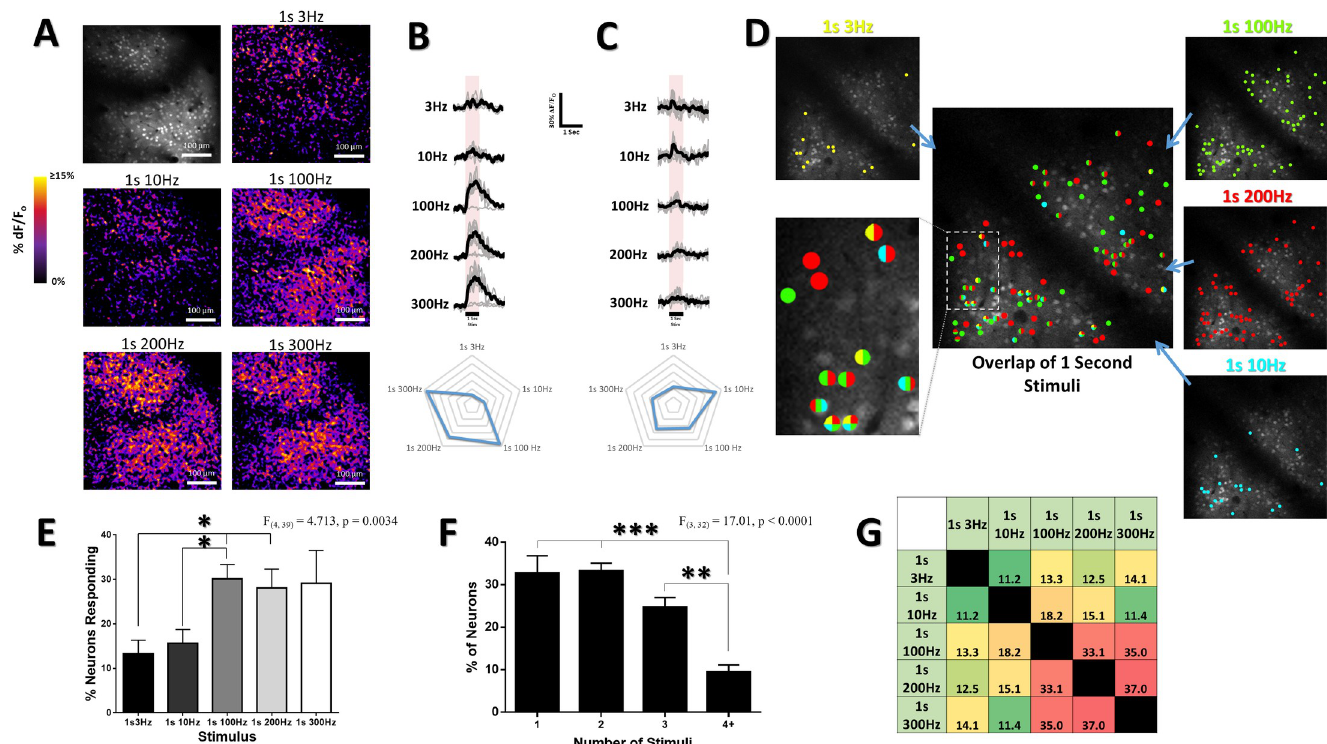
Fig 2. Neuronal and population response selectivity to stimulus frequency within the limb associated somatosensory cortex. ( A ) Difference images illustrating the averaged change in fluorescence Δ F/F o from baseline over the 1s stimulus period. Top left panel depicts an averaged image of the baseline period prior to stimulus onset within the cHL responsive region at 130um depth in an example animal. High frequency 100, 200, & 300Hz stimuli elicit greater cortical activation of neurons and neuropil than lower frequency 3 & 10Hz stimuli (quantified in Fig 3). ( B , C ) Ca 2+ traces for individual neurons responding to the different stimuli (average of 8 trials of stimulation per limb) are shown for each stimulus for the particular chosen neuron. The neuron in B is more responsive to high frequency 100, 200, & 300Hz stimulation, and displays minimal response to lower frequency 3 and 10Hz stimuli. The neuron in C responds preferentially to 10Hz stimuli. Plots below Ca 2+ traces indicate peak Ca 2+ response magnitude for each stimulus ( D ) Color coded map of responsive neurons superimposed on an optical section at 130 μ m depth in the cHL of an example animal. Neurons were deemed responsive by threshold analysis of somatic responses, with color representing above-threshold responses to stimulation at the particular frequency and duration stated. High frequency stimuli (100 & 200Hz) elicit a greater number of neurons responsive for these stimuli. The inset image displays the same color code used for each particular stimulus and shows how certain cells within this population are selective in their response to particular stimuli, whereas others display overlap in their responsiveness to multiple different stimuli. ( E ) Mean percent of neurons responding to each of our stimuli across all animals (N = 10). ( F ) Mean percent of neurons within each optical section responsive to 1, 2, 3, or 4+ stimuli across all animals (N = 10). ( G ) Color coded chart displaying the percentage overlap between the neurons responsive to each stimulus for all animals (N = 10). High frequency 100, 200, & 300Hz stimuli display greater overlap in their responsive cell populations as compared to the activated cell population overlap for 3Hz and 10Hz stimuli. � p < 0.05; �� p < 0.01; ��� p <